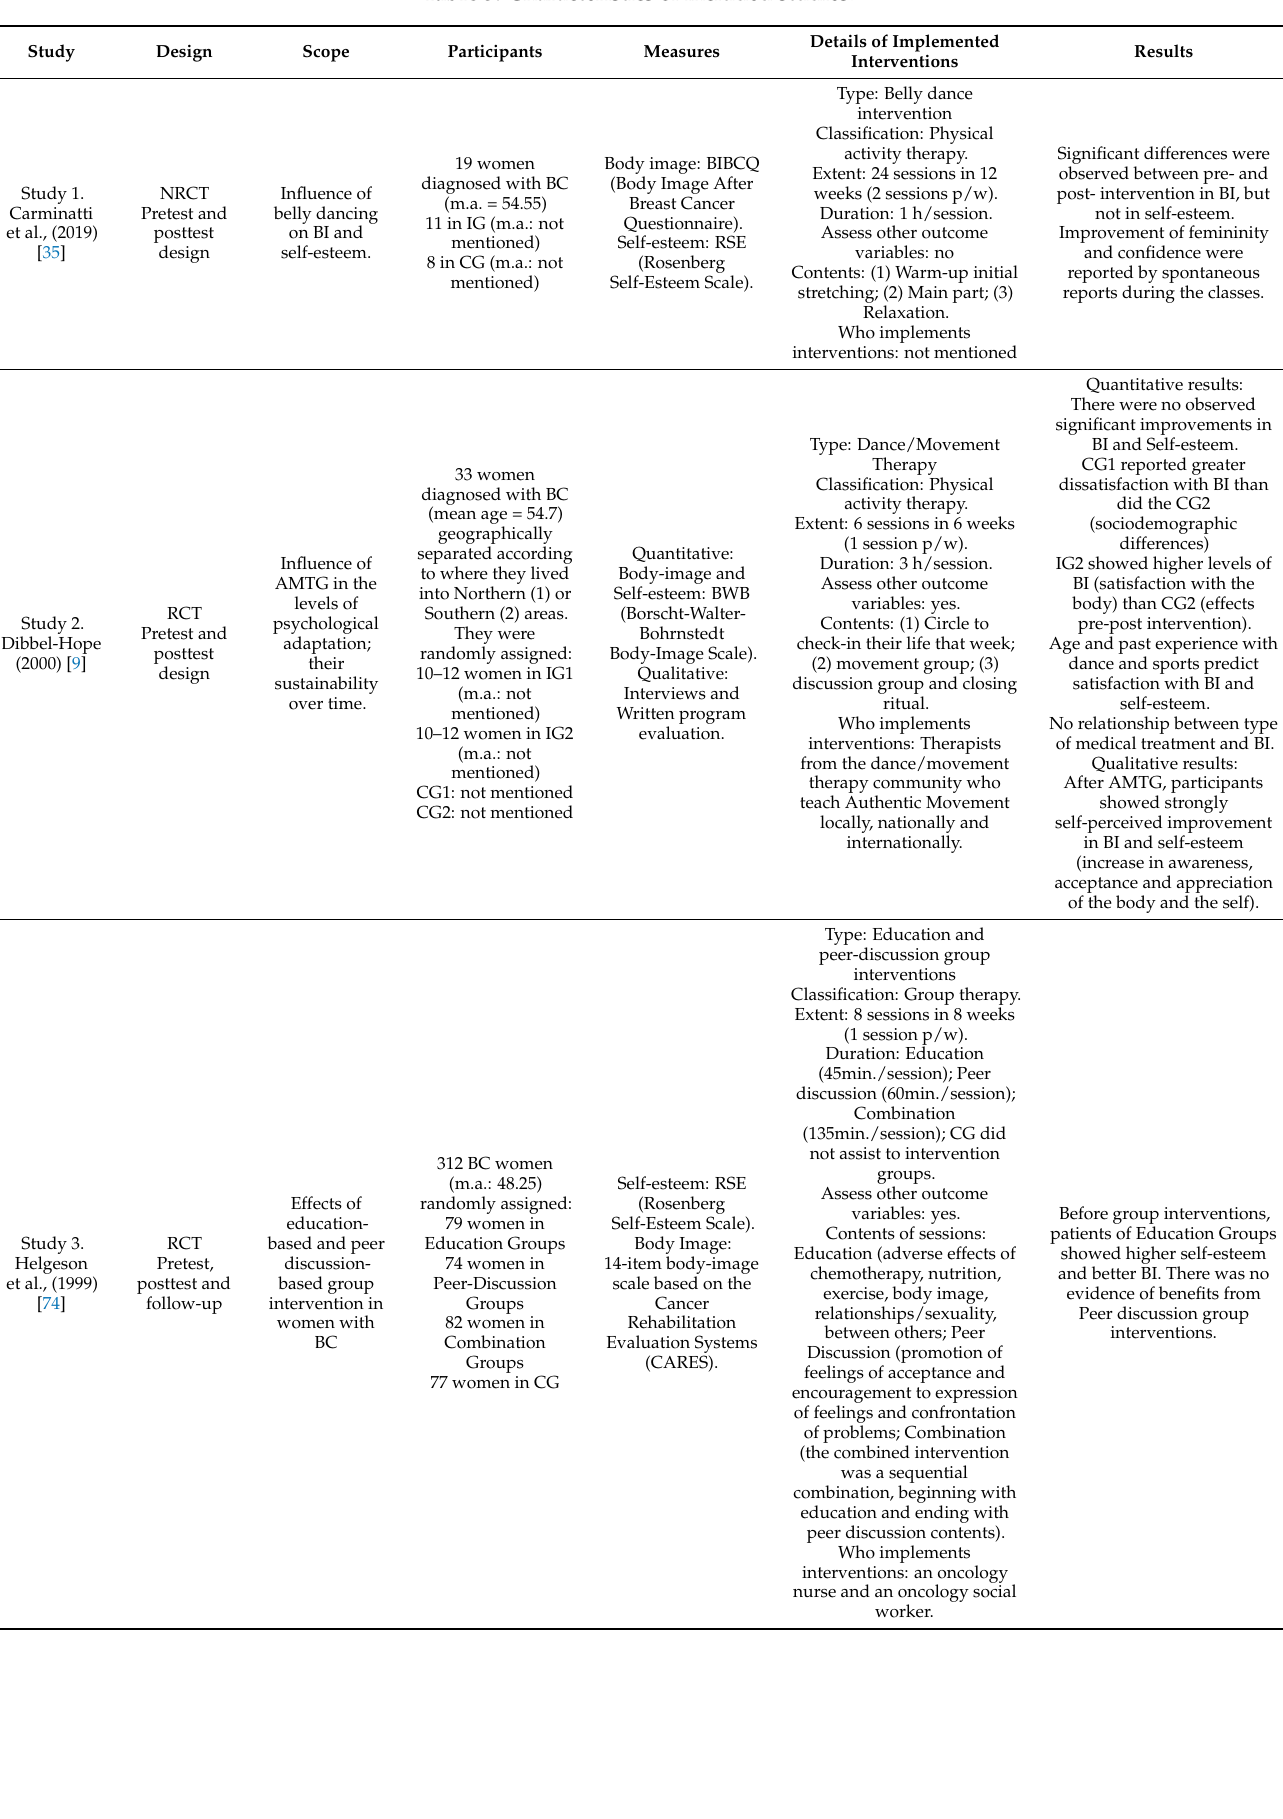
Table 3. Characteristics of included